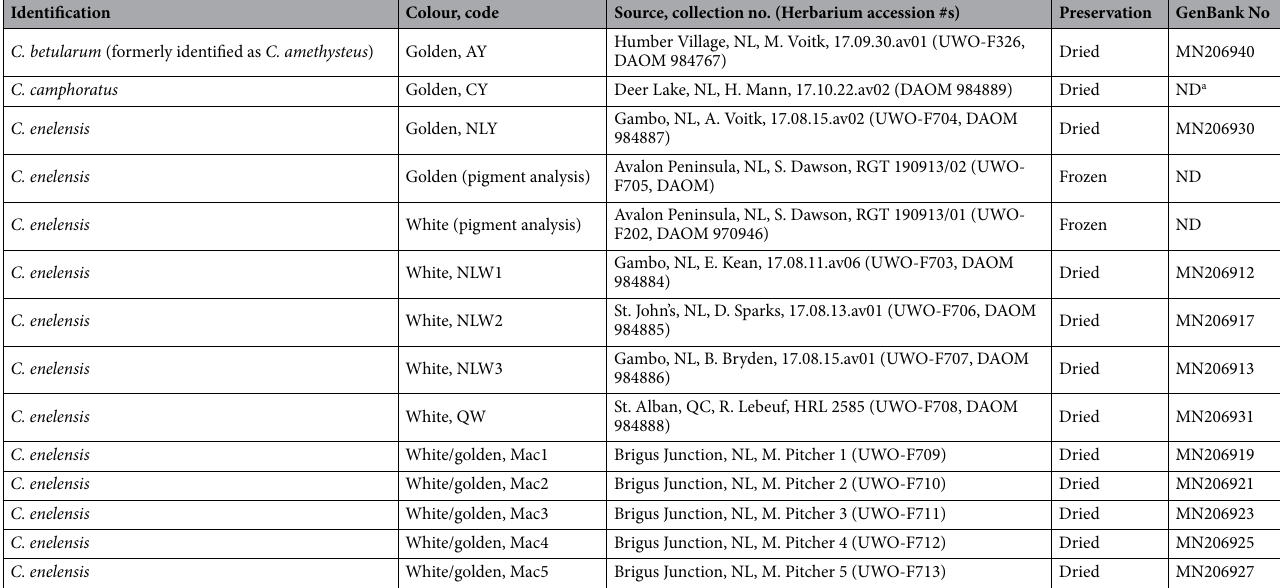
Table 1. Cantharellus specimens used for chemical analyses, their colour, source, preservation conditions, and GenBank accession number of reference ITS sequence. Specimens labelled white/golden are white or golden individuals from a mixed collection of both white and golden chanterelles that were indistinguishable after desiccation. NL Newfoundland & Labrador, QC Québec. a 18.09.13.av07 (UWO-F703), from same population,